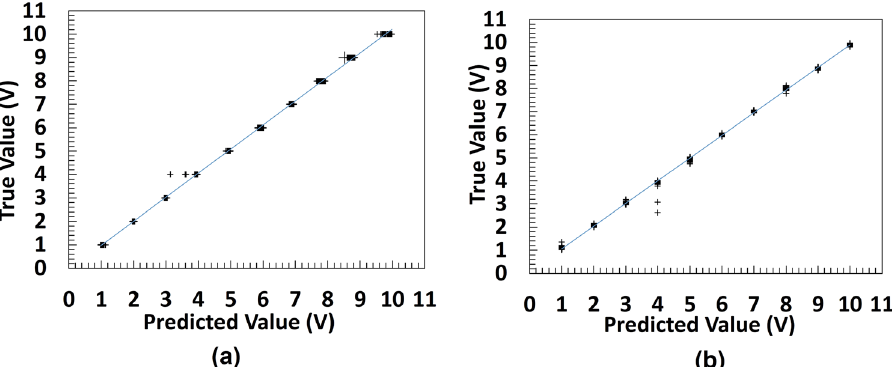
Figure 8. Line of best fit of the best deep regression models ( a ) ResNet-50 with RMSProp ( b ) ResNet-50 with